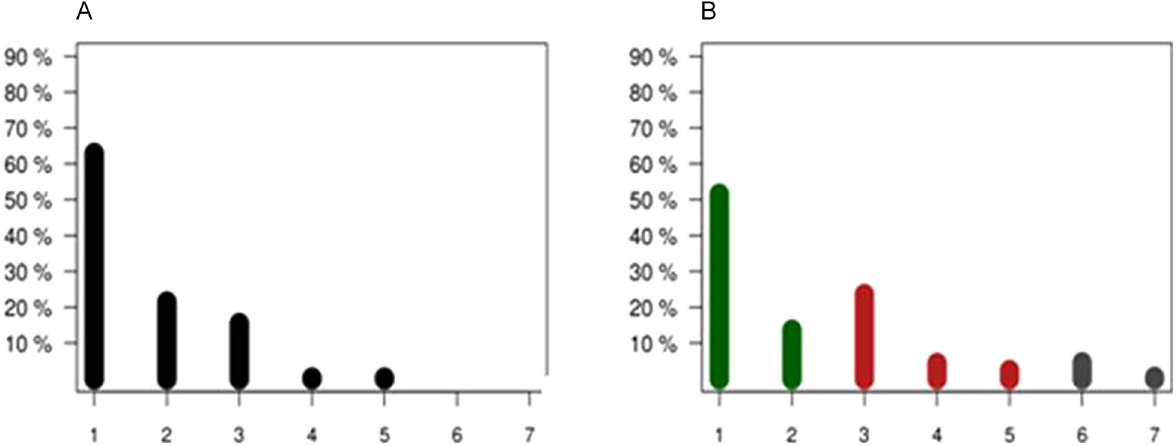
Fig. 4. The share of particular types of land use in the structure of the pre-mining (A) and mining (B) Adamów- Koźmin